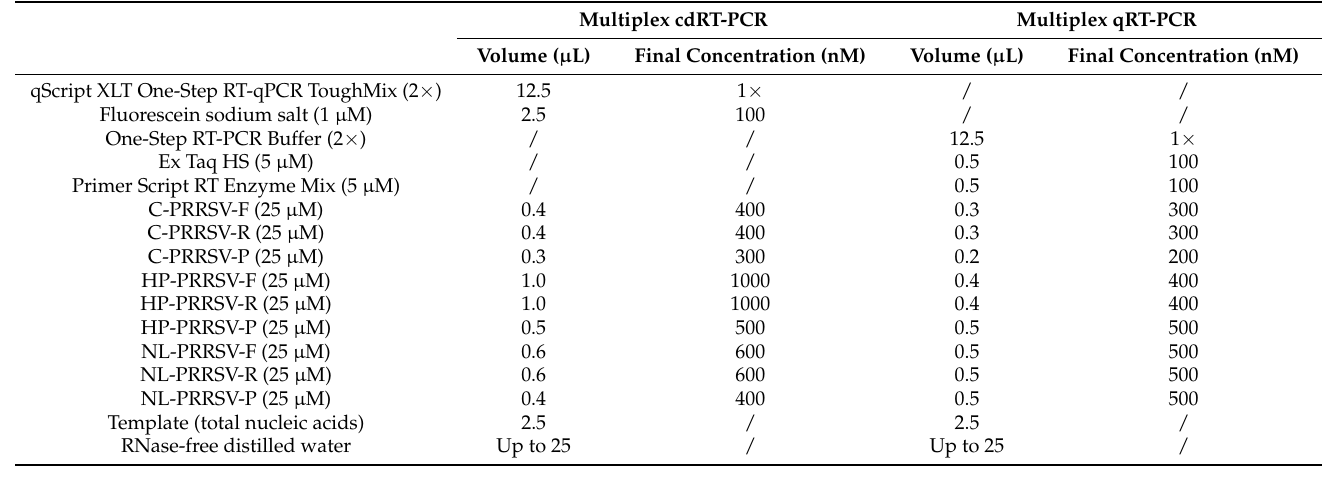
Table 2. The reaction system of the multiplex cdPCR and the multiplex qRT-qPCR.